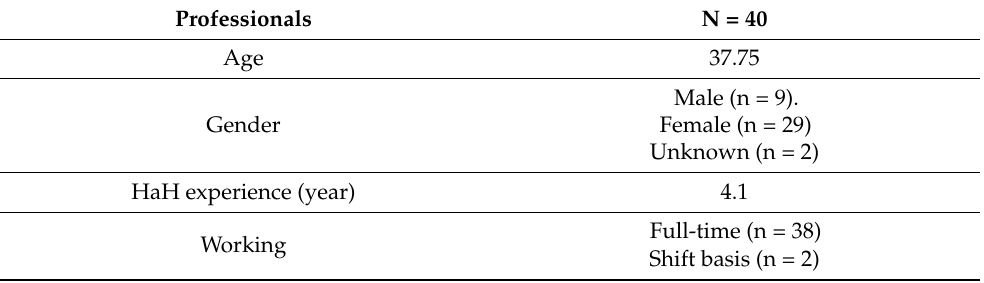
Table 6. Sociodemographic characteristics of professionals.